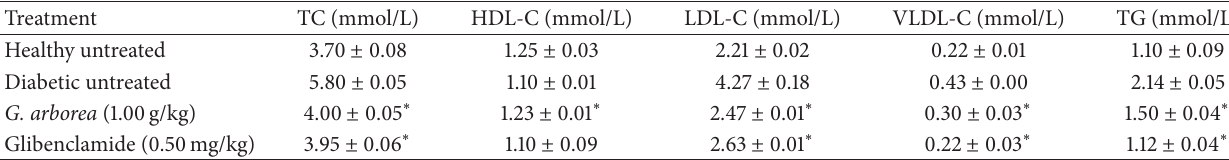
Table 2: Lipid profile in diabetic rats after 30 days of treatment.